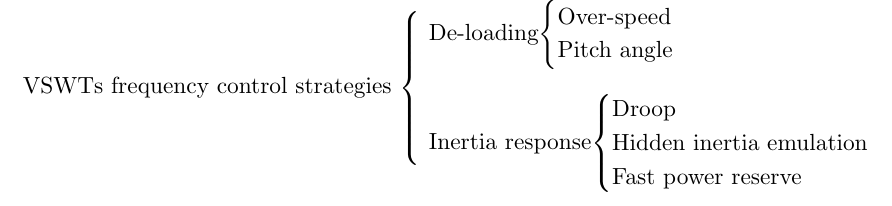
Figure 1. General classification for Variable Speed Wind Turbines (VSWTs) frequency control